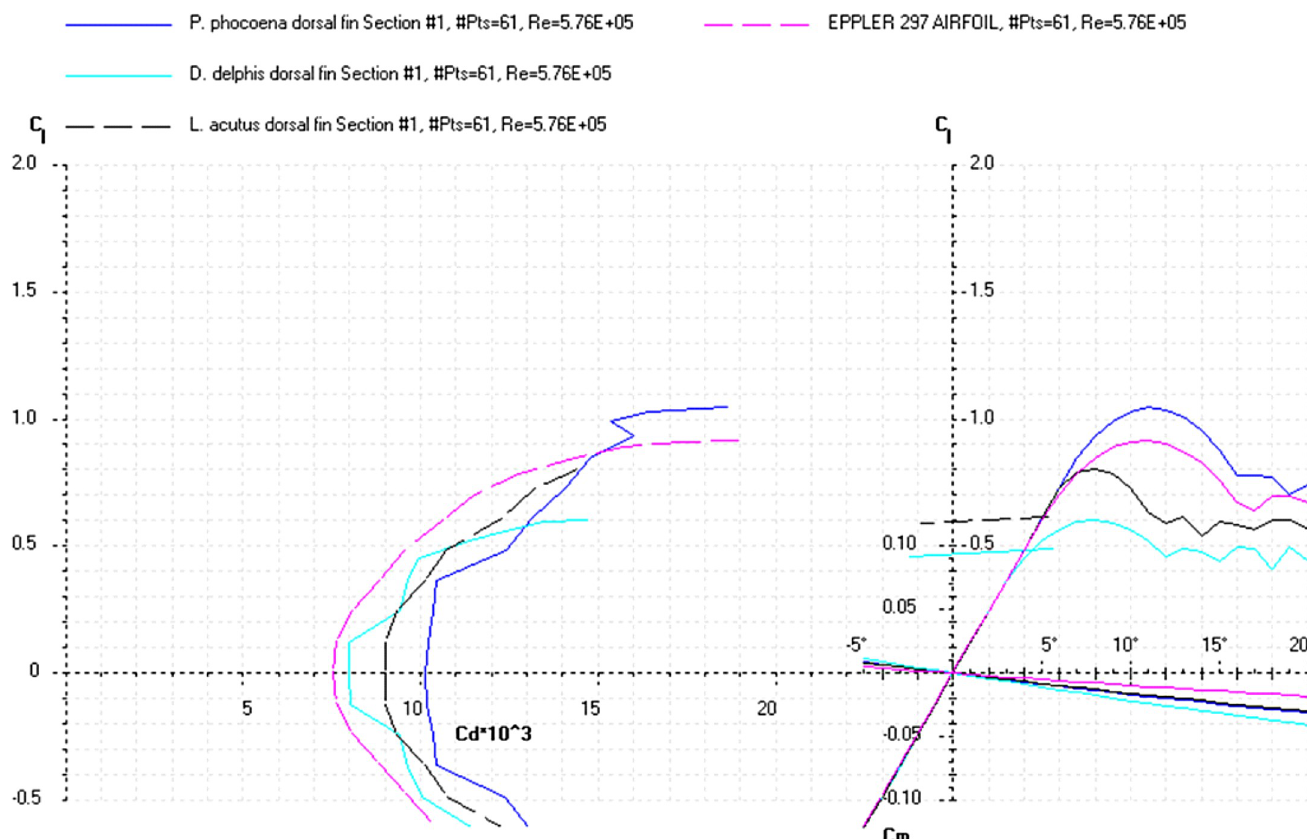
Fig 12. Drag polar diagram of lift CL vs drag Cd. Calculated for the cross-sections taken at the base of the dorsal fin of the P . phocoena , D . delphis , L . acutus and Eppler 297 airfoil at the averaged Re 5.76E+05 for the fin cross-sections (Table 9).